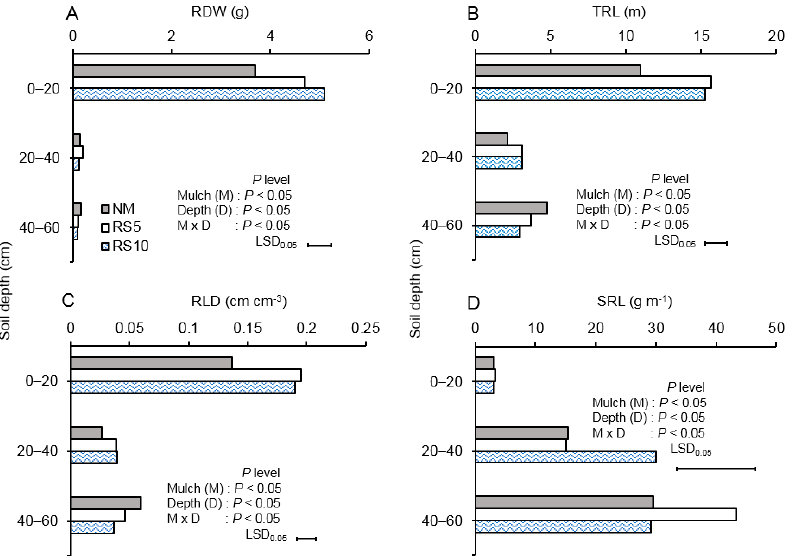
Figure 7. Effects of mulch treatments on root parameters at different soil depths at bud formation (at 58 DAS) in 2018 – 2019: ( A ) mean root dry weight (RDW), ( B ) total root length (TRL), ( C ) root length density (RLD), and ( D ) specific root length (SRL). LSD 0.05 is the least significant difference of the interaction between mulch and depth. NM = no-mulch; RS5 = rice straw ~5 t ha − 1 ; RS10 = rice straw ~10 t ha − 1 .